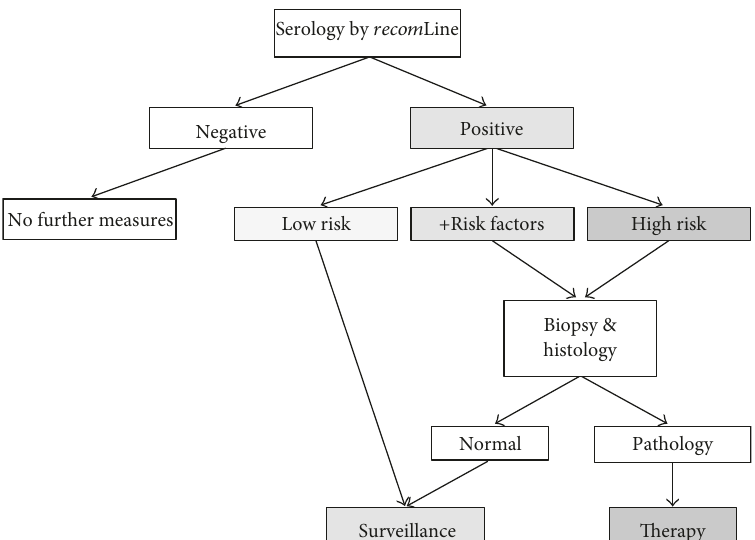
Figure 5: H. pylori diagnostic decision tree. Low risk: no seropositivity against CagA and VacA and no additional risk factors; +Risk factors: no seropositivity against CagA and VacA but additional risk factors such as smoking, diet, and genetic predisposition; High risk: seropositivity against CagA and